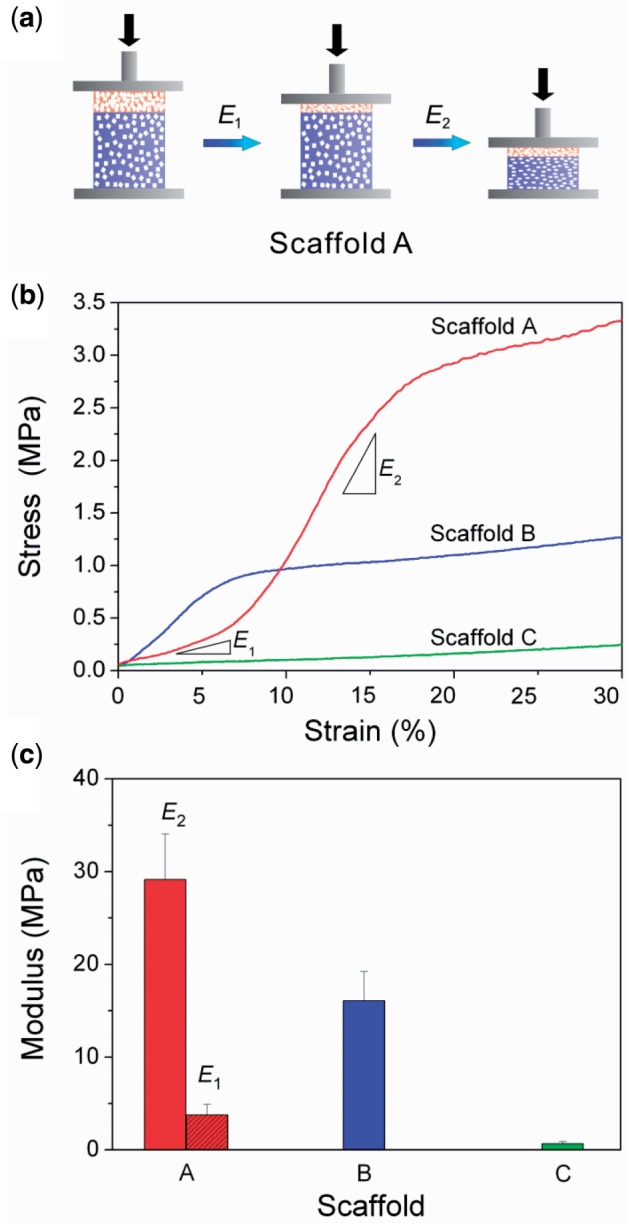
(a) Schematic presentation of the compressing process of Scaffold A. E1 represents the compressive modulus of the cartilage layer and E2 for the subchondral layer. (b) Typical stress–strain curves of three scaffolds. (c) The compressive moduli of three groups of bilayered scaffolds. n = 6 for each group.